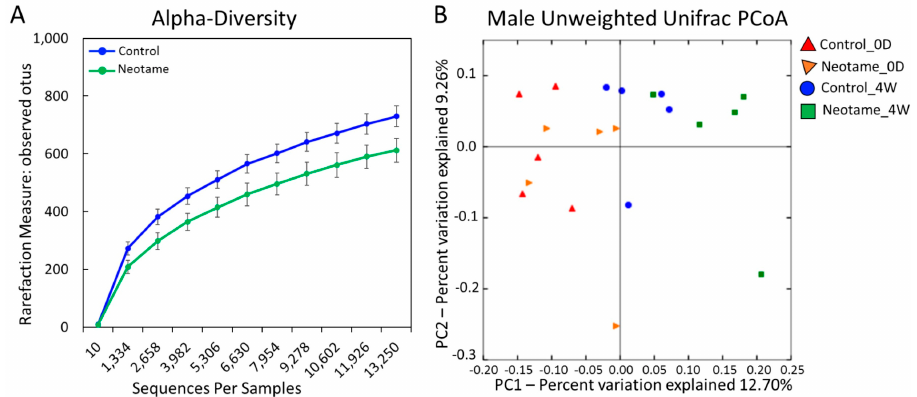
Figure 1. ( A ) The alpha-diversity of gut microbiome in neotame-treated mice was significantly lower than controls; ( B ) The PCoA analysis (beta-diversity) indicated a difference of gut microbiome communities in control and treated mice after four-week neotame consumption.